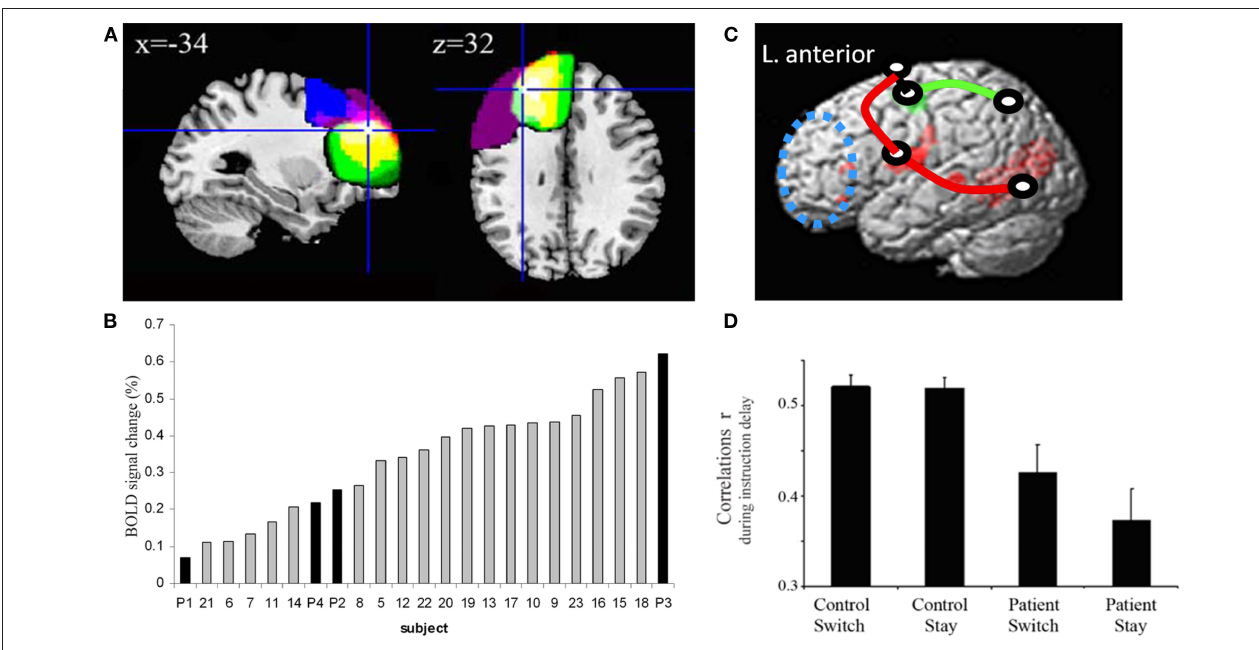
lower in four patients (black bars) compared with health controls (gray bars). However, the correlations among five surviving regions (C) associated with verbal set (red) or spatial set (green) were reduced in patients (D) , especially when the same task set was repeated in subsequent trials (stay trials) (Rowe et al.,